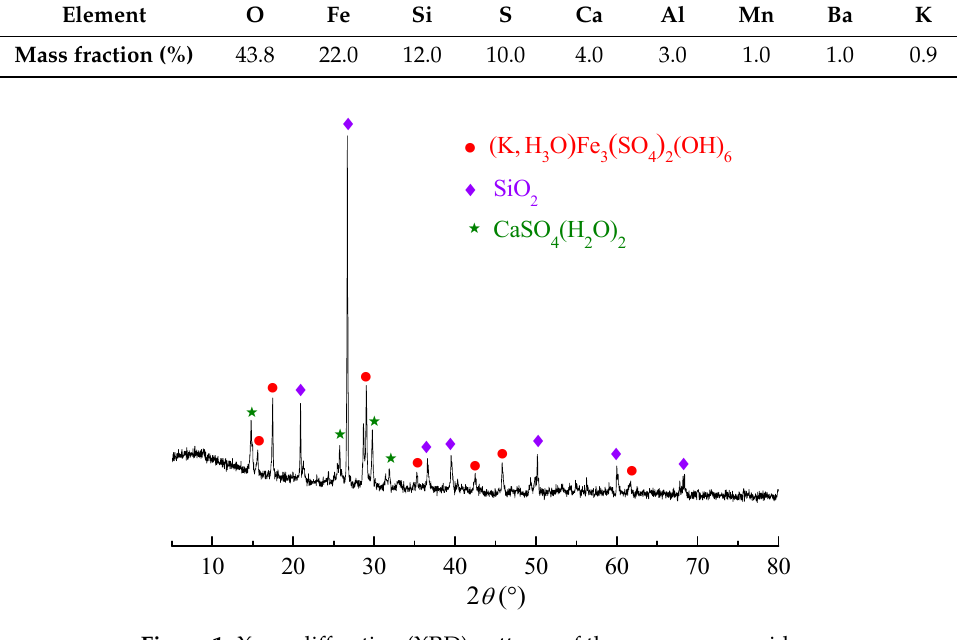
Figure 1. X-ray di ff raction (XRD) patterns of the manganese Figure 1. X ‐ ray diffraction (XRD) patterns of the manganese residue.